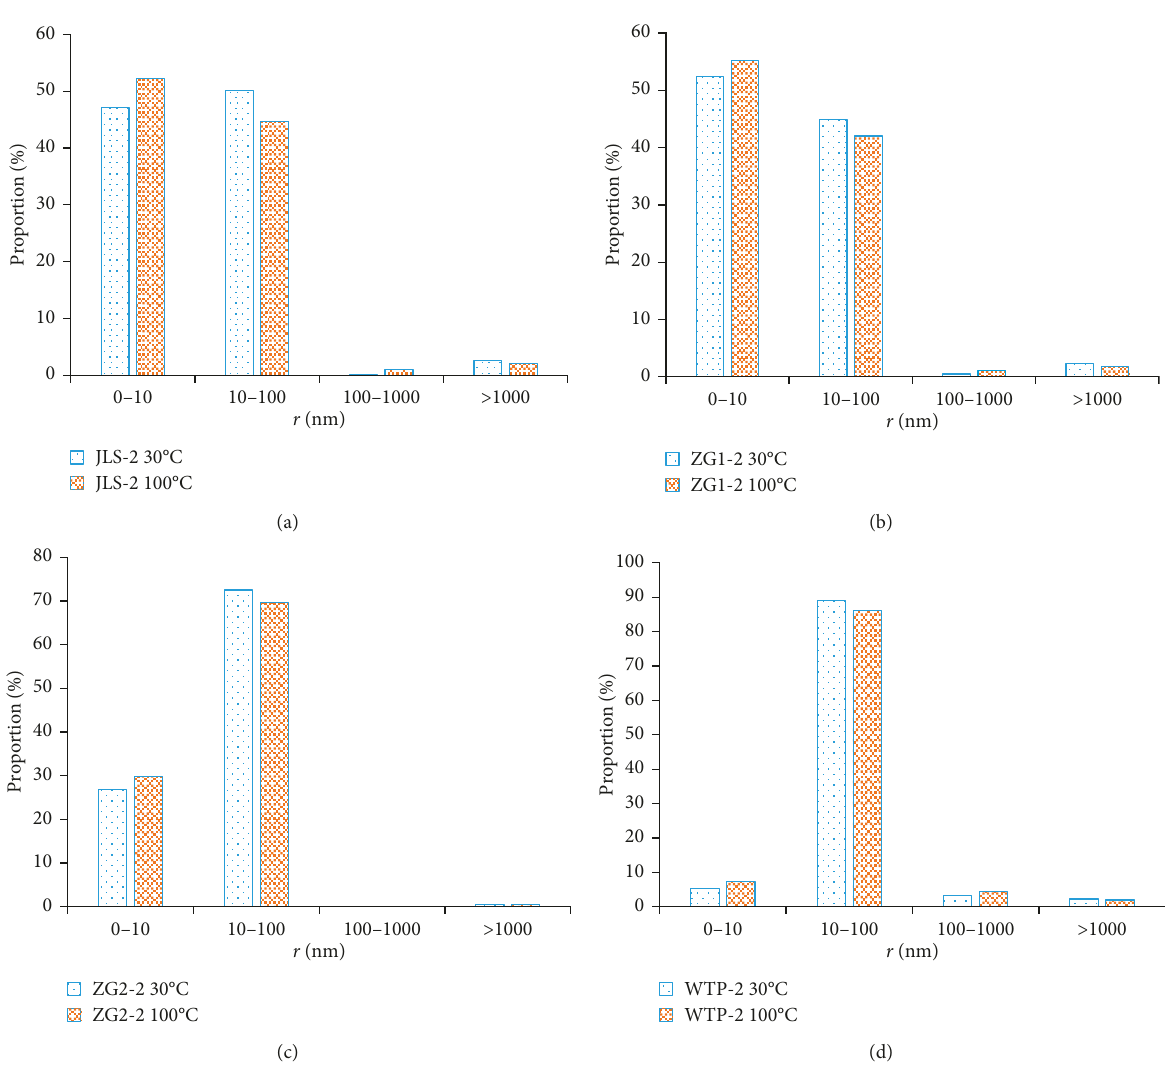
Figure 4: Histogram of pore size distribution of coal samples under high-temperature